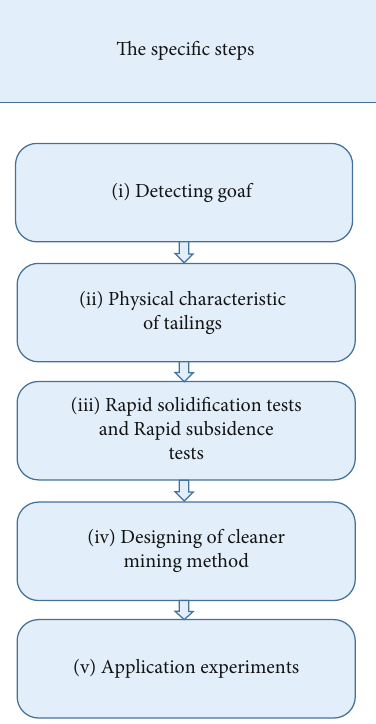
Figure 2: The speci fi c steps of more economical and cleaner